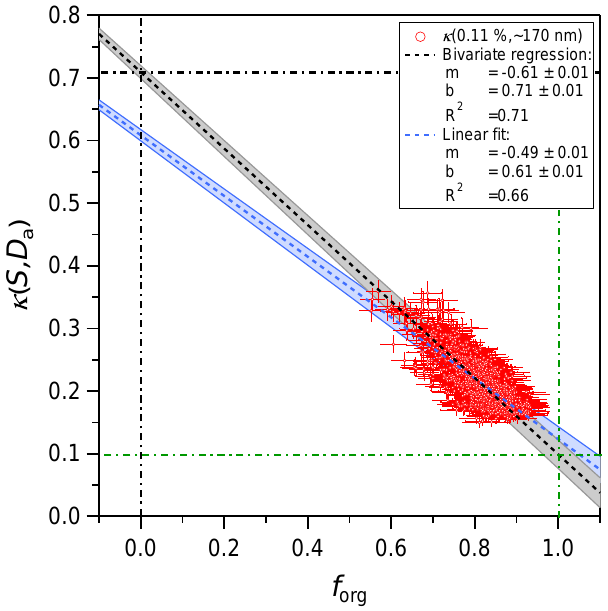
Figure 8. Correlation between κ (0.11%, ∼ 170nm) and the organic mass fraction, f org , determined by the ACSM during the dry season months. The data were fitted by a linear and a bivariate regression fit. Shading of the fit lines shows the standard error of the fit. The er- ror bars of the data markers represent the experimental error, which is estimated as 5% for f org and 10% for κ (0.11%, ∼